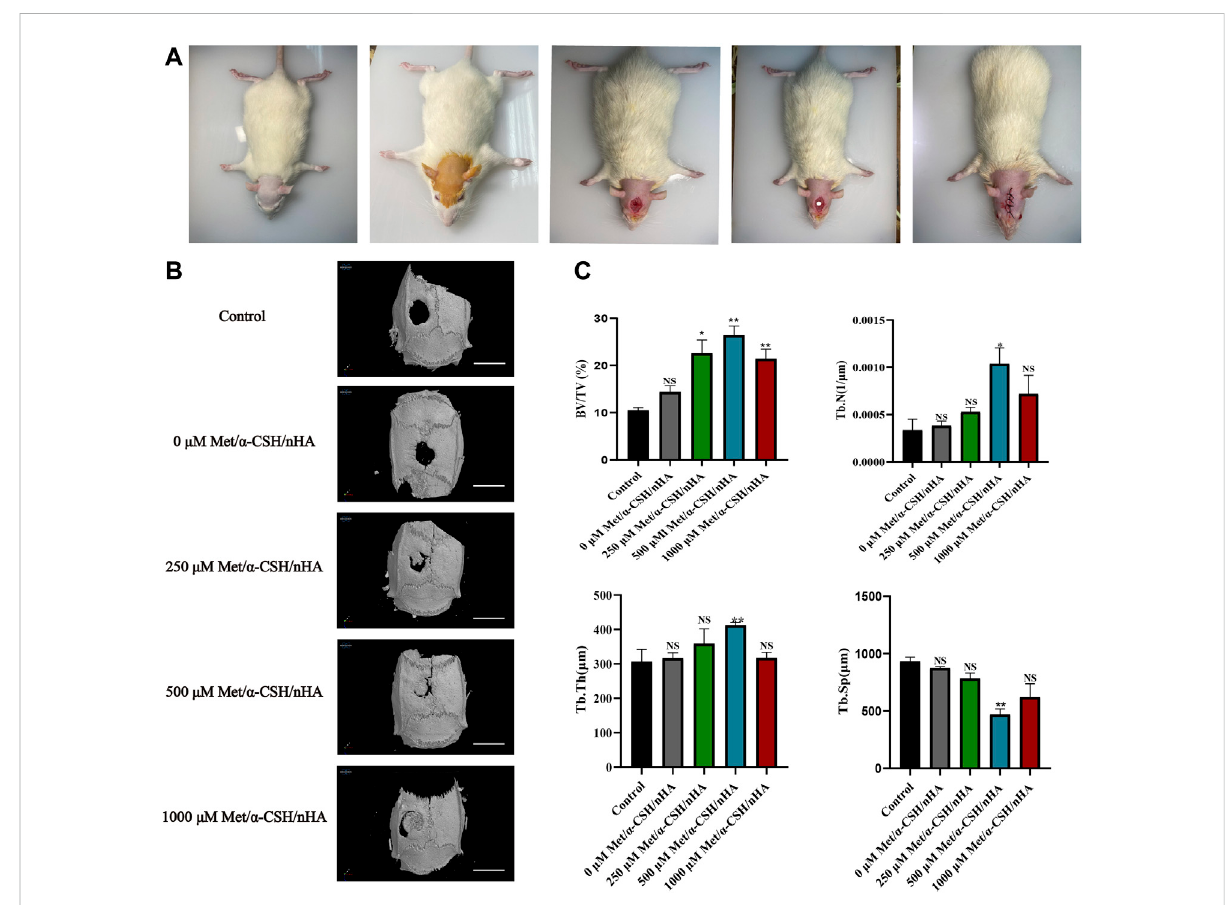
FIGURE 4 Preparation of SD rat skull defect model and micro-CT results after 10 weeks. The preparation of the rat cranial defect is shown in (A) . The micro-CT demonstrates the repair of the cranial defect at 10 weeks (B) (Scale bar = 5 mm) and was statistically analysed (C) .* p < 0.05 and ** p < 0.01 compared with the control